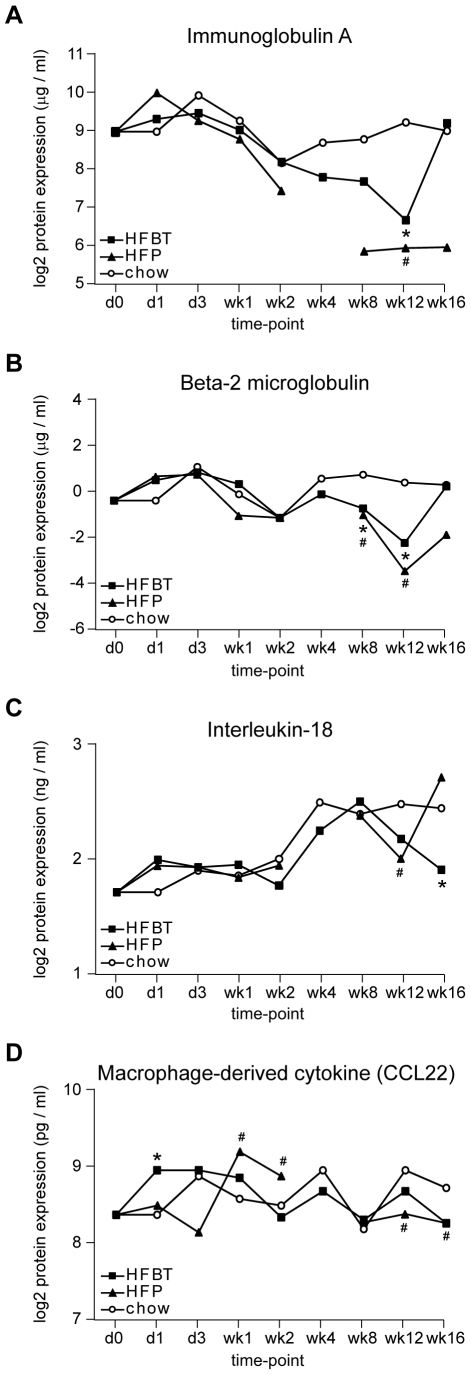
Expression changes of plasma proteins caused by HFBT and HFP high-fat diets.Expression changes of a subset of inflammatory plasma proteins that show trend of early activation coupled with late repression compared to the control condition during the 16-week high-fat (HF) feeding time-course, as measured by multiplex immunoassay. Plotted are average protein expression levels per time point in mice fed chow, HFBT and HFP diets. Statistically significant changes in protein expression of HFBT and HFP fed mice compared to chow fed mice per time-point are marked with asterisk and hash symbol, respectively (p value<0.05). All four proteins are associated with NF-κB activation. (A) Immunoglobulin A, protein that activates NF-κB. (B–D) Beta-2 microglobulin, Interleukin-18 and Macrophage-derived chemokine (CCL22), proteins activated by NF-κB.